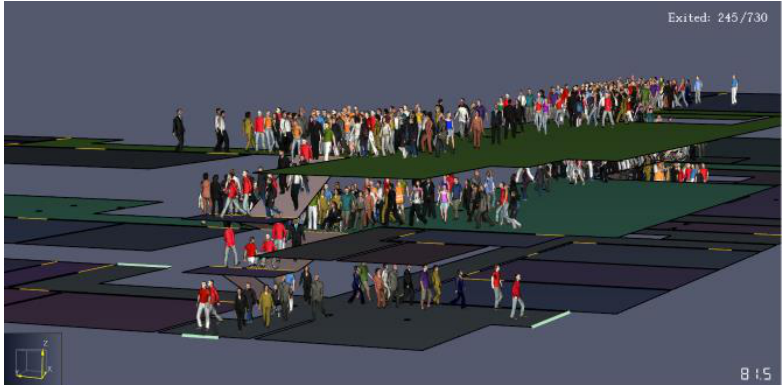
Figure 5. Original evacuation situation map.